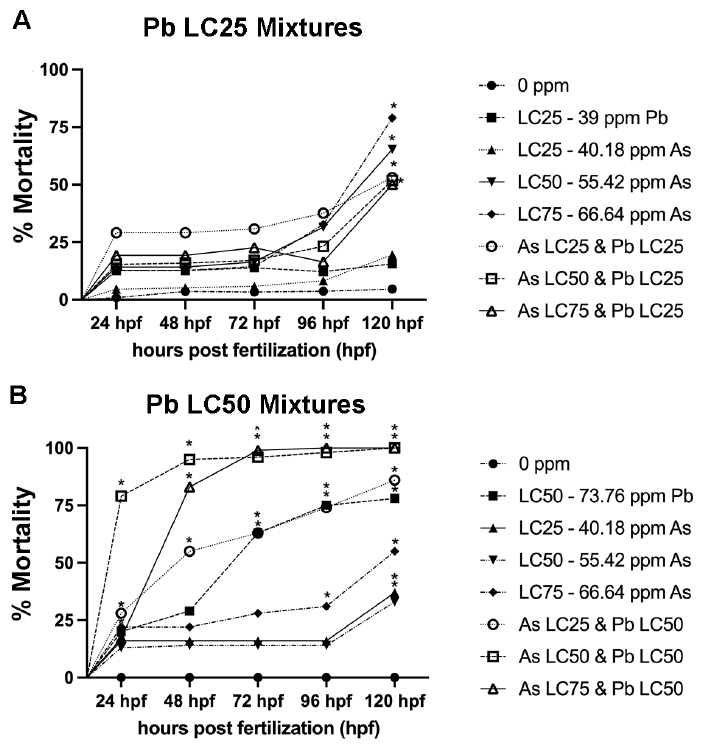
Figure 3. Percent mortality for mixture experiments assessed every 24 h from 1–120 h post fertilization (hpf). Mixture experiments in which Pb was held constant at the 120 hpf-LC 25 (39.0 ppm) in experiment 1 ( A ) and in which Pb was held constant at the 120 hpf-LC 50 (73.76 ppm) in experiment 2 ( B ), while As was varied to include the 120 hpf-LC 25 , 120 hpf-LC 50 , and 120 hpf-LC 75 . N = 3 biological replicates for each treatment group with 50 subsamples per each treatment group. Data is presented as mean ± standard deviation. * p < 0.05.